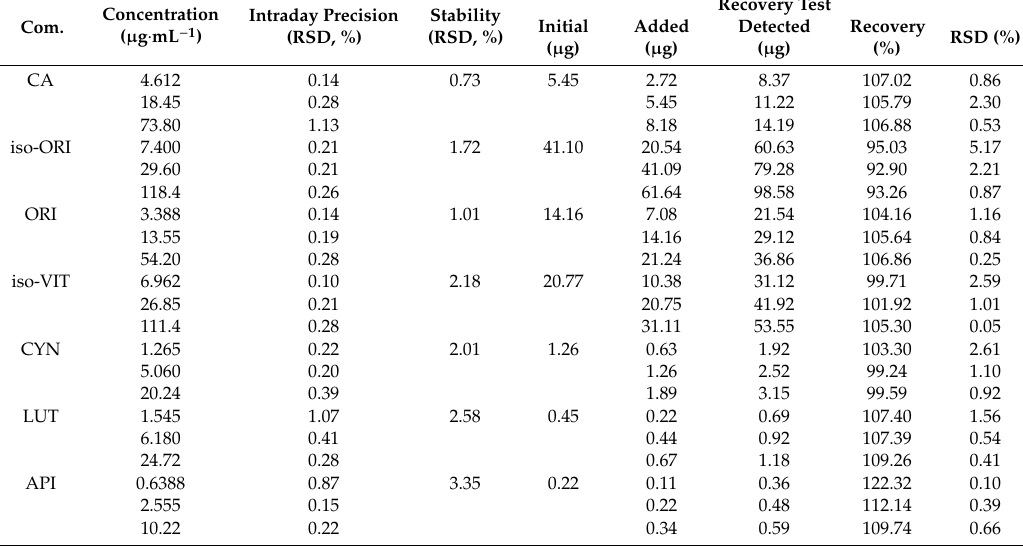
Table 2. The results of the precision, stability, and recovery